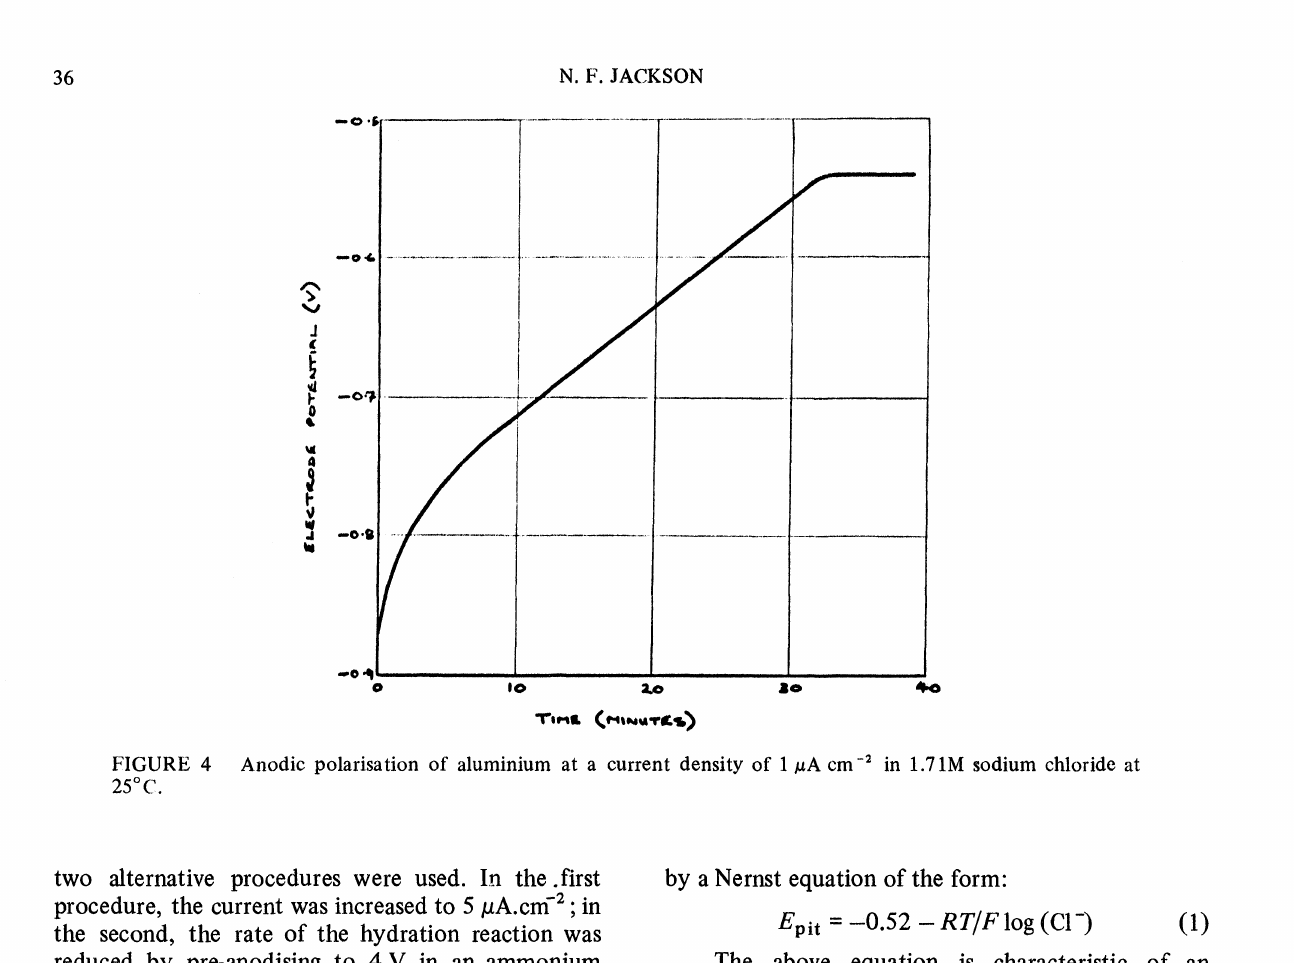
FIGURE 4 Anodic polarisation of aluminium at a current density of A cm 25C.